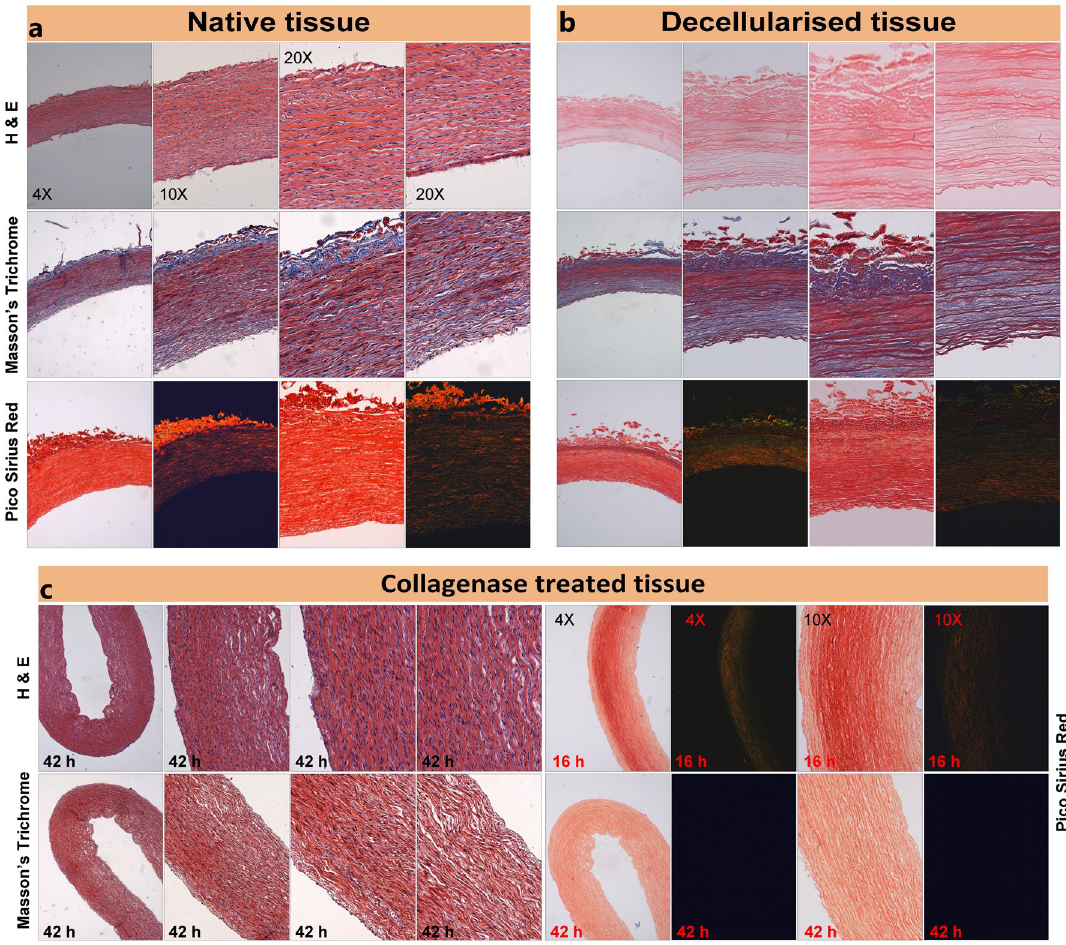
Figure 1. Histological ring sections of porcine common carotid artery. ( a ) Native tissues, ( b ) decellularized tissues and ( c ) collagenase treated tissues were stained with hematoxylin and eosin (H&E) to visualize the cell density. Picrosirius red stain (PSR) was used to visually observe the collagen content under polarized light and Masson’s Trichrome stain was used to further validate the observations. (Histological images are from different samples and are representative